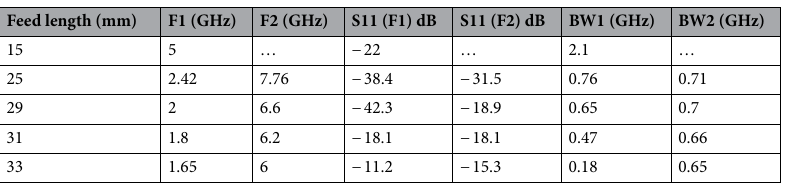
Table 6. Electrical properties of Antenna1 using a feedline length as a